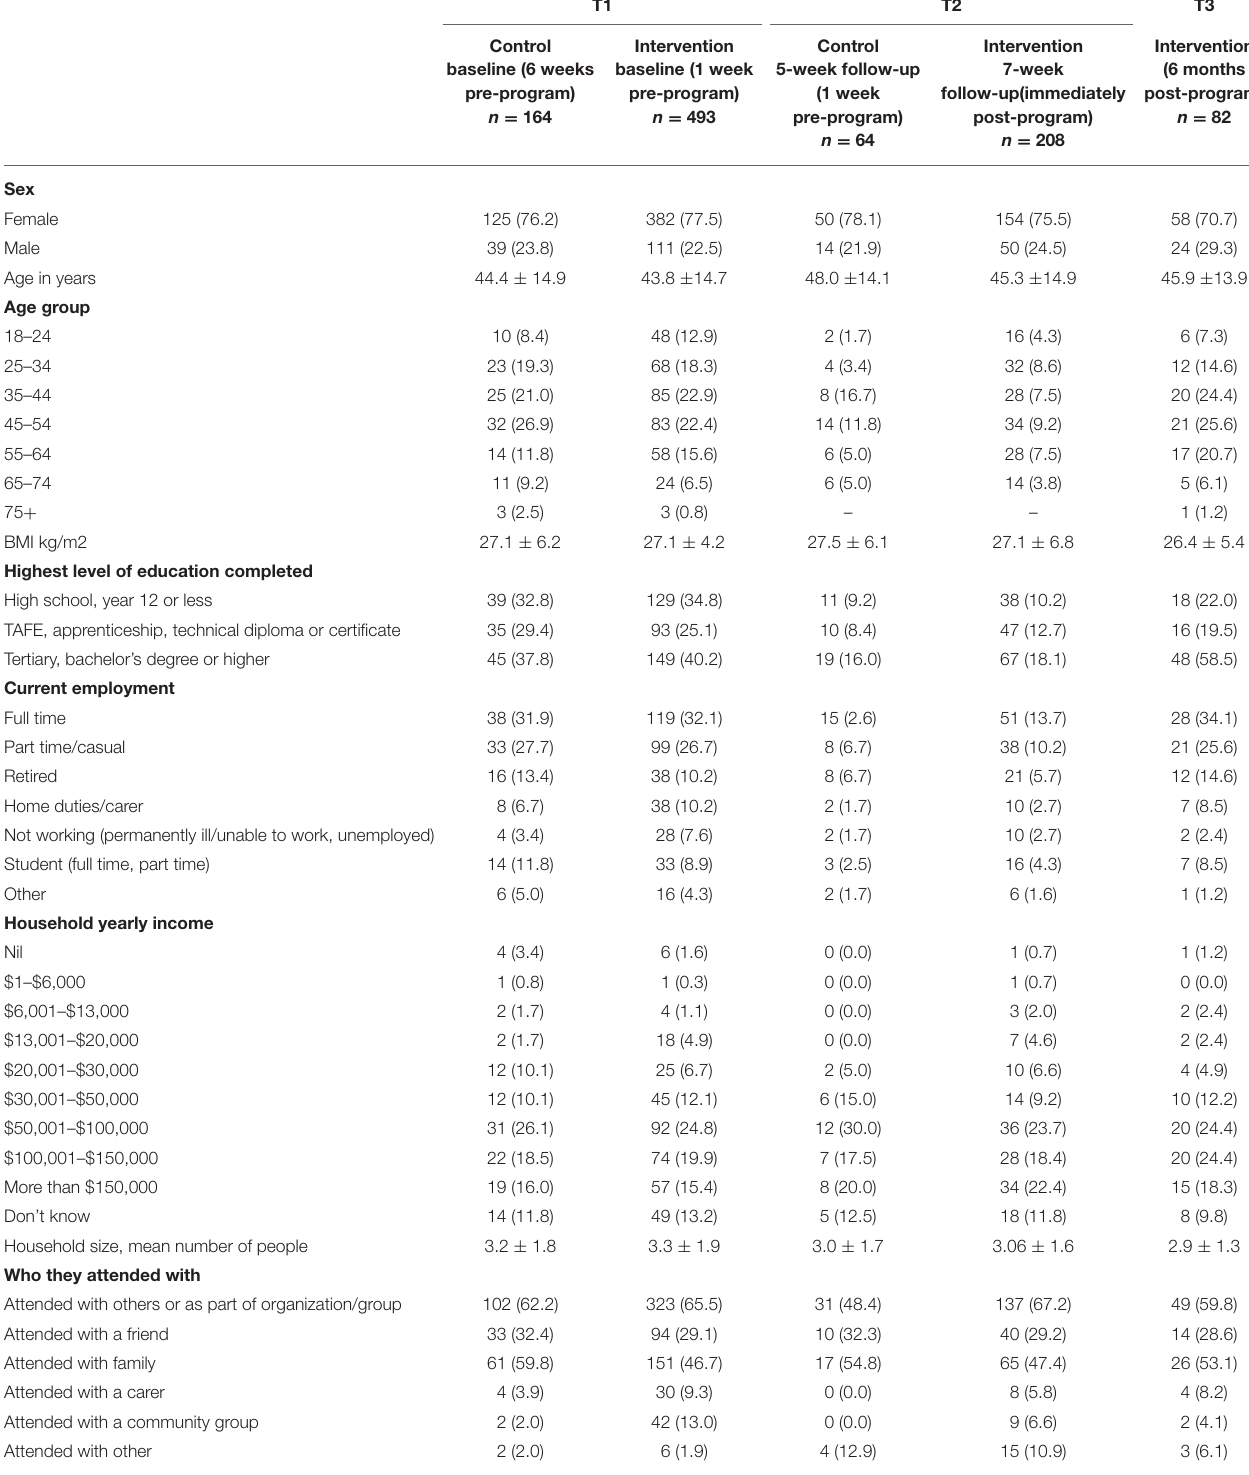
TABLE 1 | Detailed demographic characteristics of all participants by group and at each time